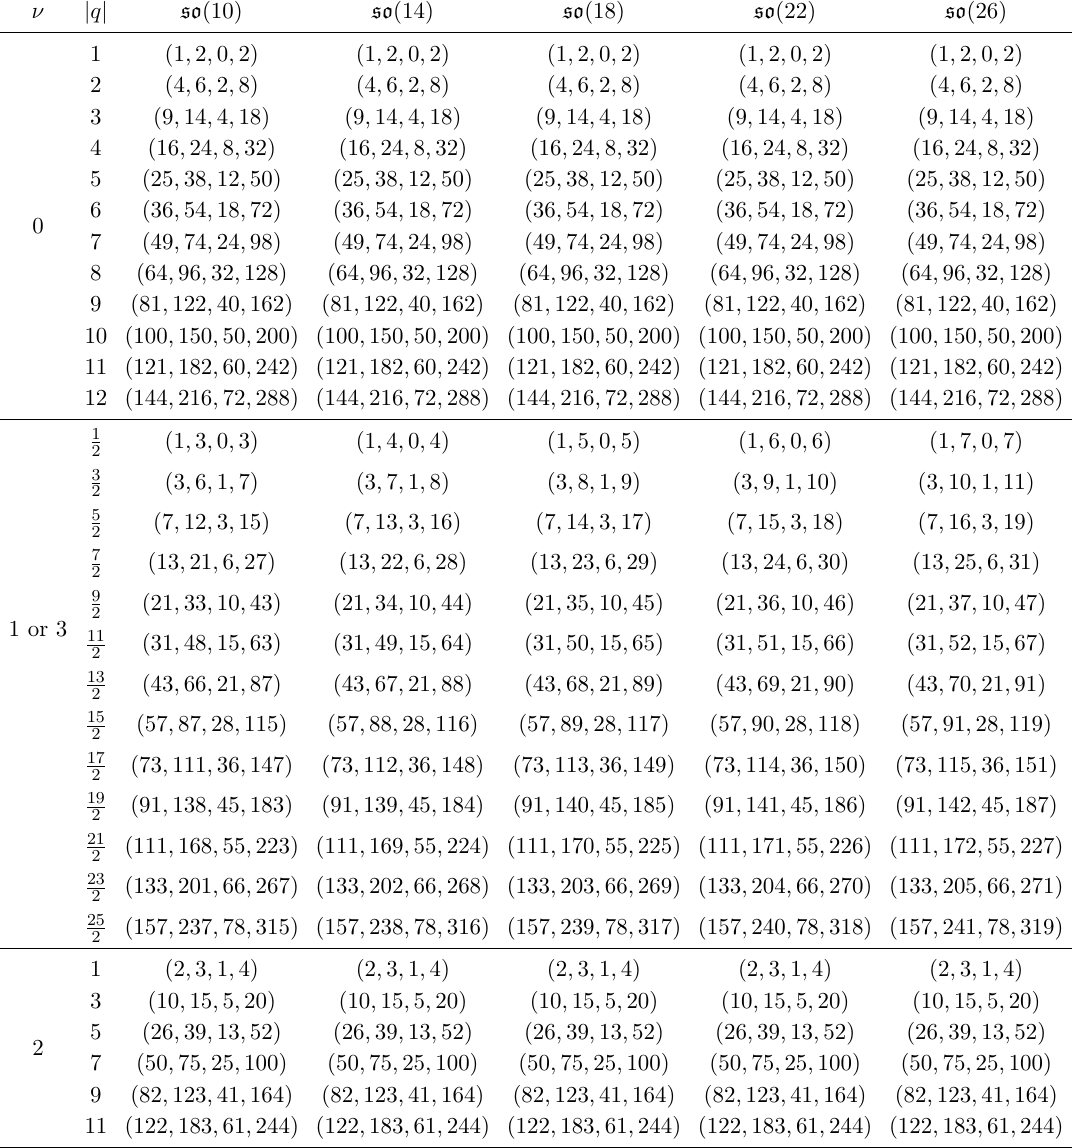
Table 18. Codimension-two orders of vanishing of (ˆ x, ˆ y, ˆ z, ˆ w ) for various pseudo-charges q of so (4 k + 2) ⊕ u (1) vector matter. This matter is supported at I ∗ s